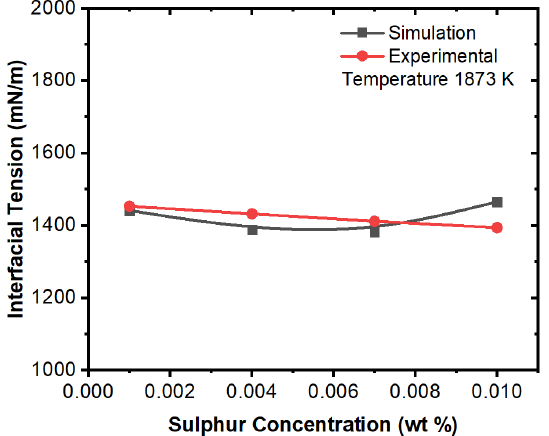
Figure 20. Comparison of experimental and simulation results of interfacial tension with respect to sulfur concentration (temperature 1873 K, experimental work by Jeong et al. [26]).